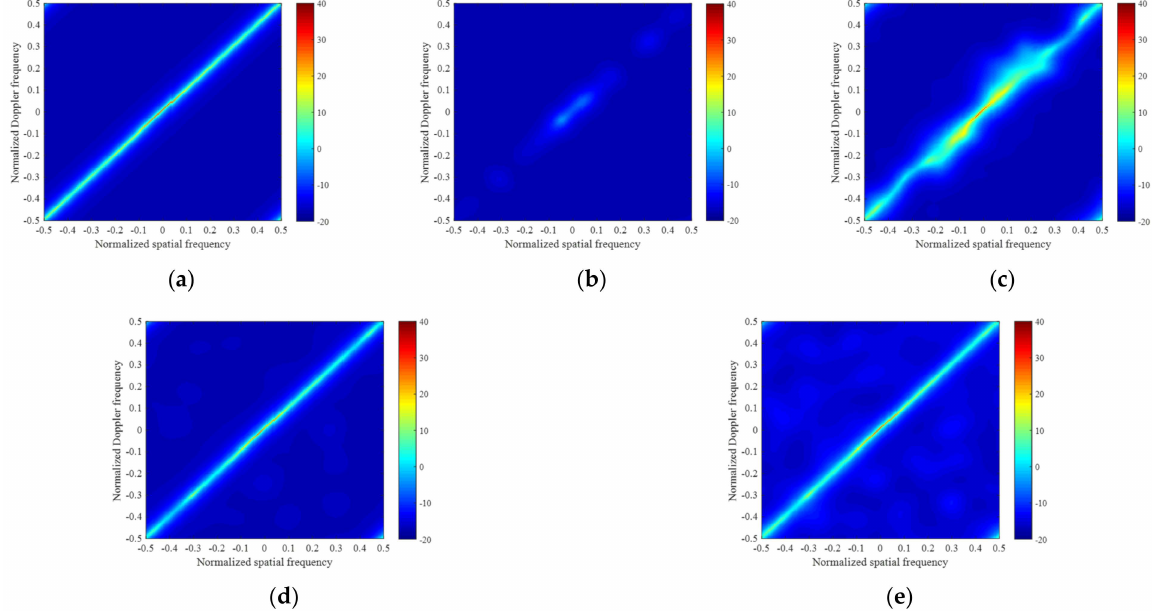
Figure 2. Angle-Doppler clutter power spectrums in the ideal case: ( a ) exact spectrum calculated by the ideal CNCM; ( b ) sparse spectrum estimated by LSMI; ( c ) sparse spectrum estimated by M- OMP-STAP; ( d ) sparse spectrum estimated by M-SBL-STAP; and ( e ) sparse spectrum estimated by